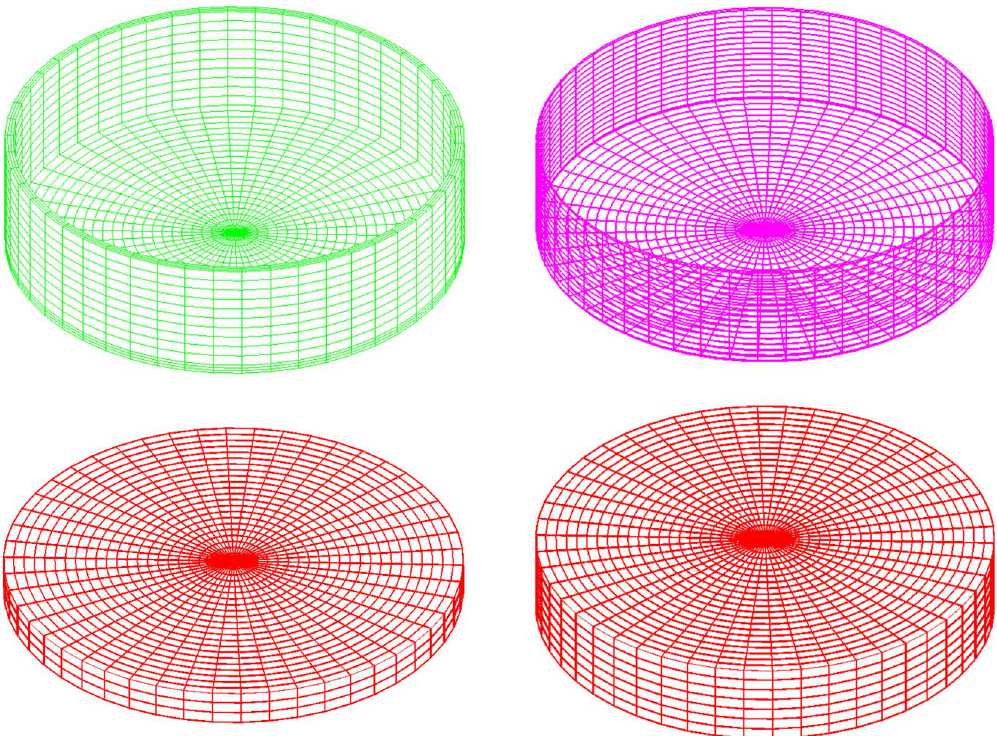
Fig 6. The finite element models of tank A. a) Tank body. b) Reinforcement bar. c) 30% water storage. d) 70% water storage.